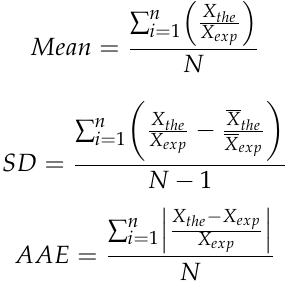
Figure 6. Comparison of